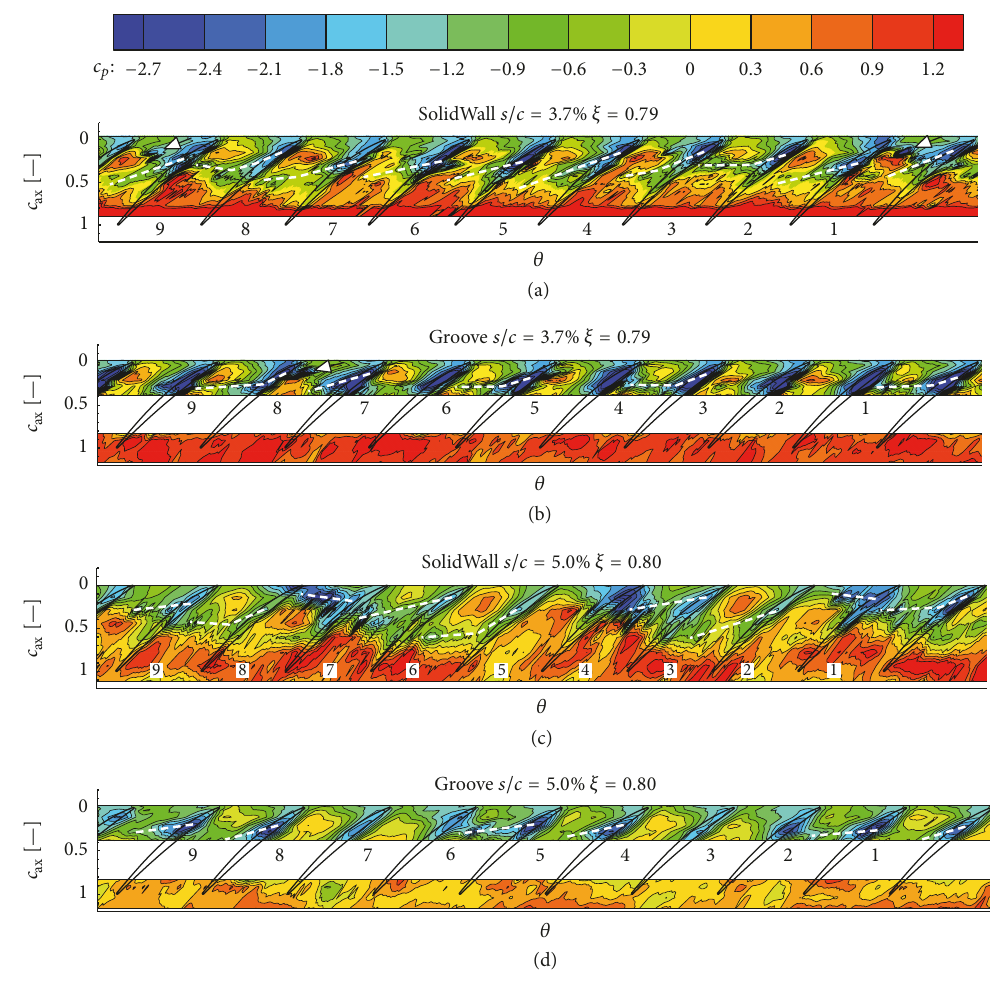
Figure 10: Time-resolved casing static pressure over rotor for SolidWall and Groove at 𝑠/𝑐 = 3.7% (a, b) and 𝑠/𝑐 = 5.0% (c, d). SolidWall operating points are near stall, Groove operating points identical to